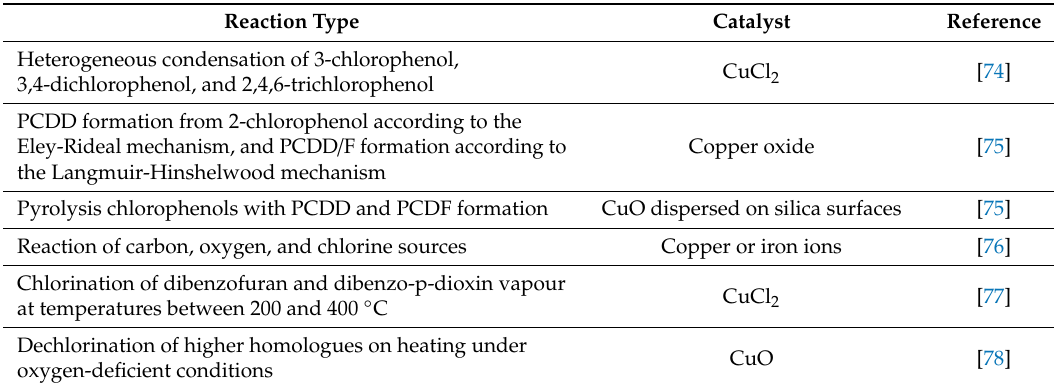
Table 2. Reactions that result in the formation of polychlorinated dibenzo-p-dioxins (PCDDs) and polychlorinateddibenzofurans